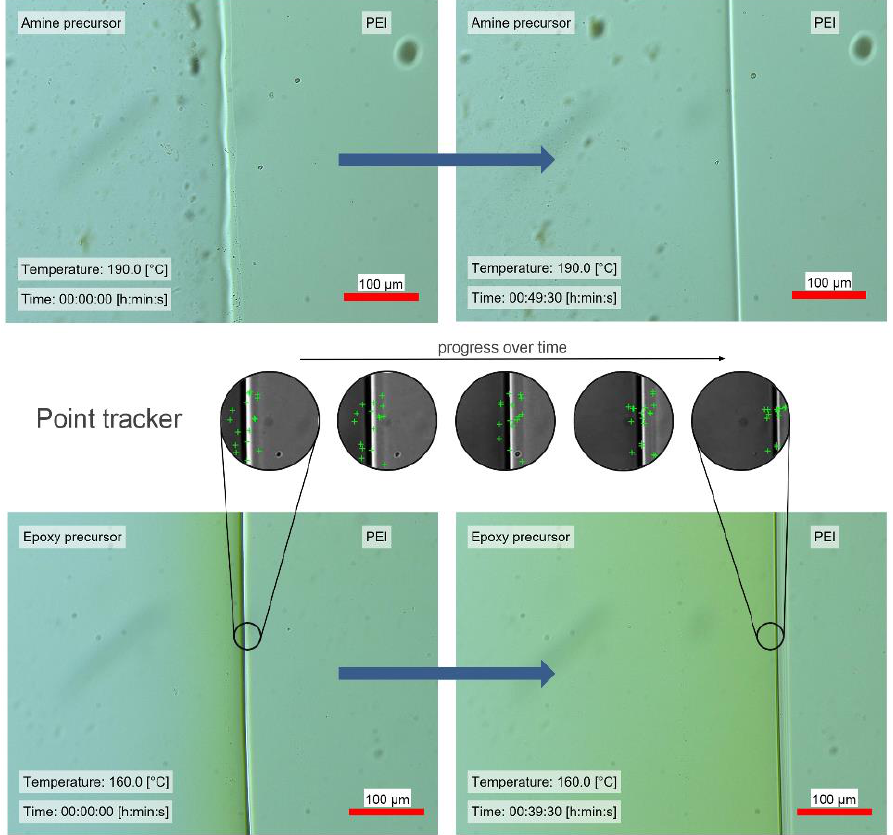
Figure 4. Monocomponent diffusion experiments of chosen precursors with PEI. From top to bottom: diffusion of amine precursor at 190 ◦ C; point tracker image details and epoxy precursors at 160 ◦ C, where the left image shows the starting time, and the right shows the diffusion after a defined time; diffusion of epoxy precursors at 160 ◦ C.